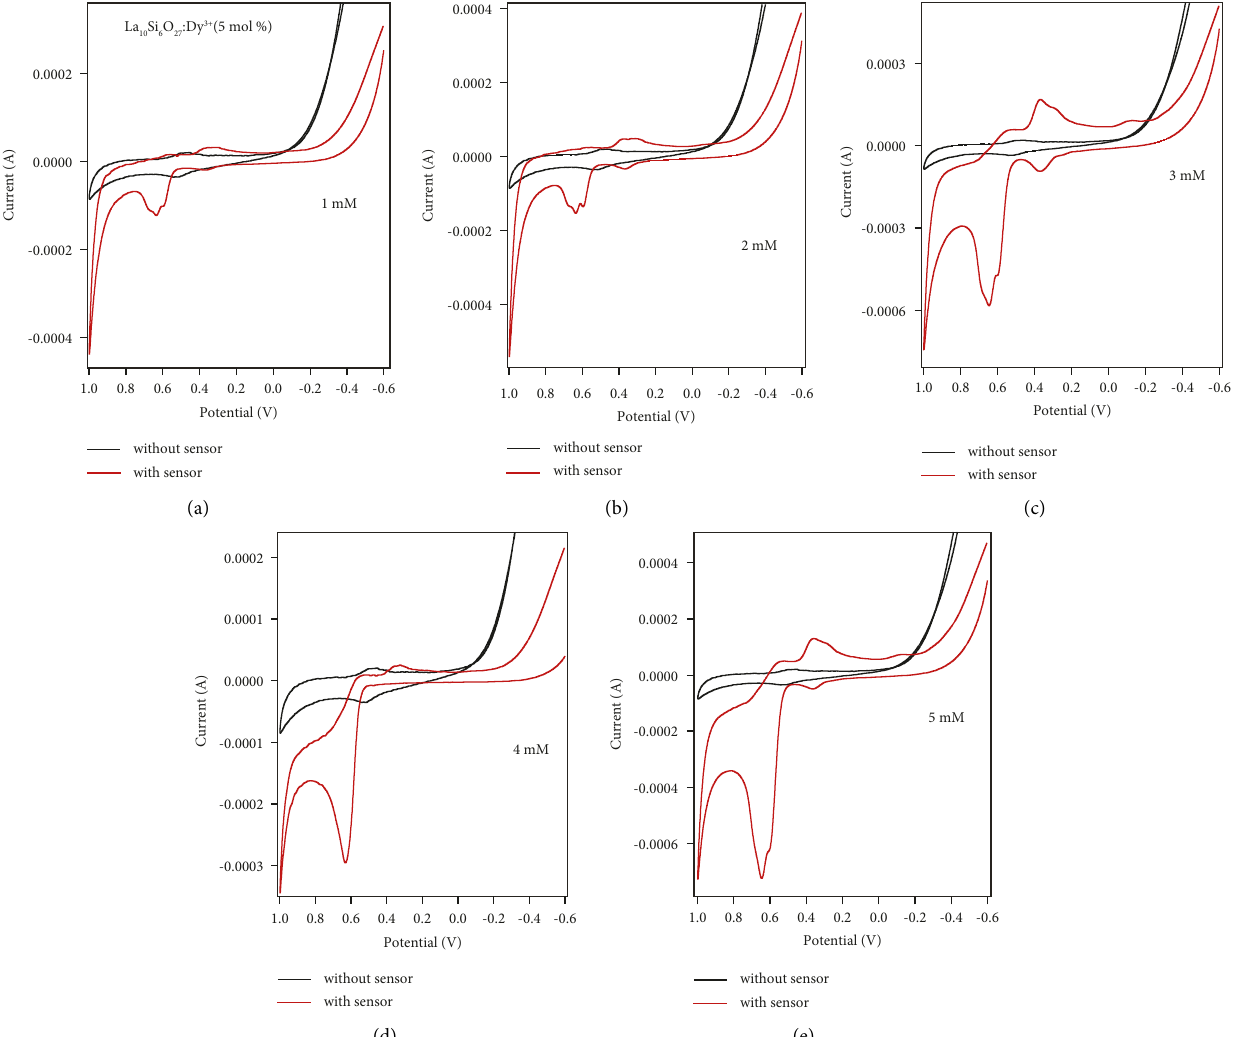
Figure 11: Cyclic voltammogram of La range